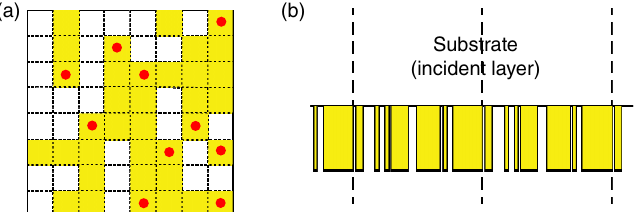
Figure 2. Automatically generated unit cells. ( a ) A 2D example; ( b ) a 1D example. The unit cell is located between the vertical broken